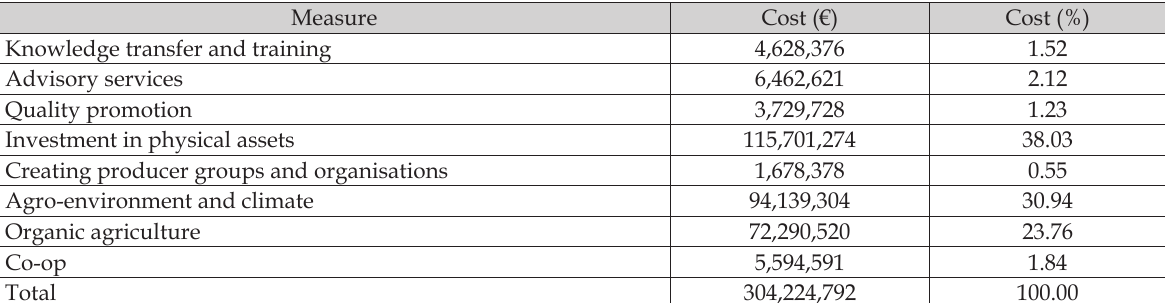
Table 6. Planned expenditure, by measure, in the 2014–2020 Rural Development Programme of Andalusia (the - matic sub-programme of the olive